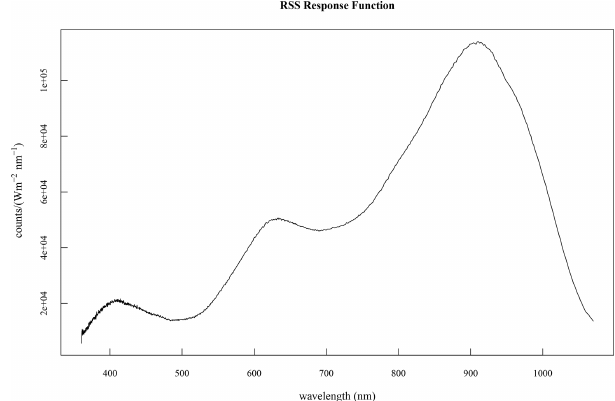
Figure 4. Measured relative response of the RSS that is needed for the interpolation scheme represented by Eq.